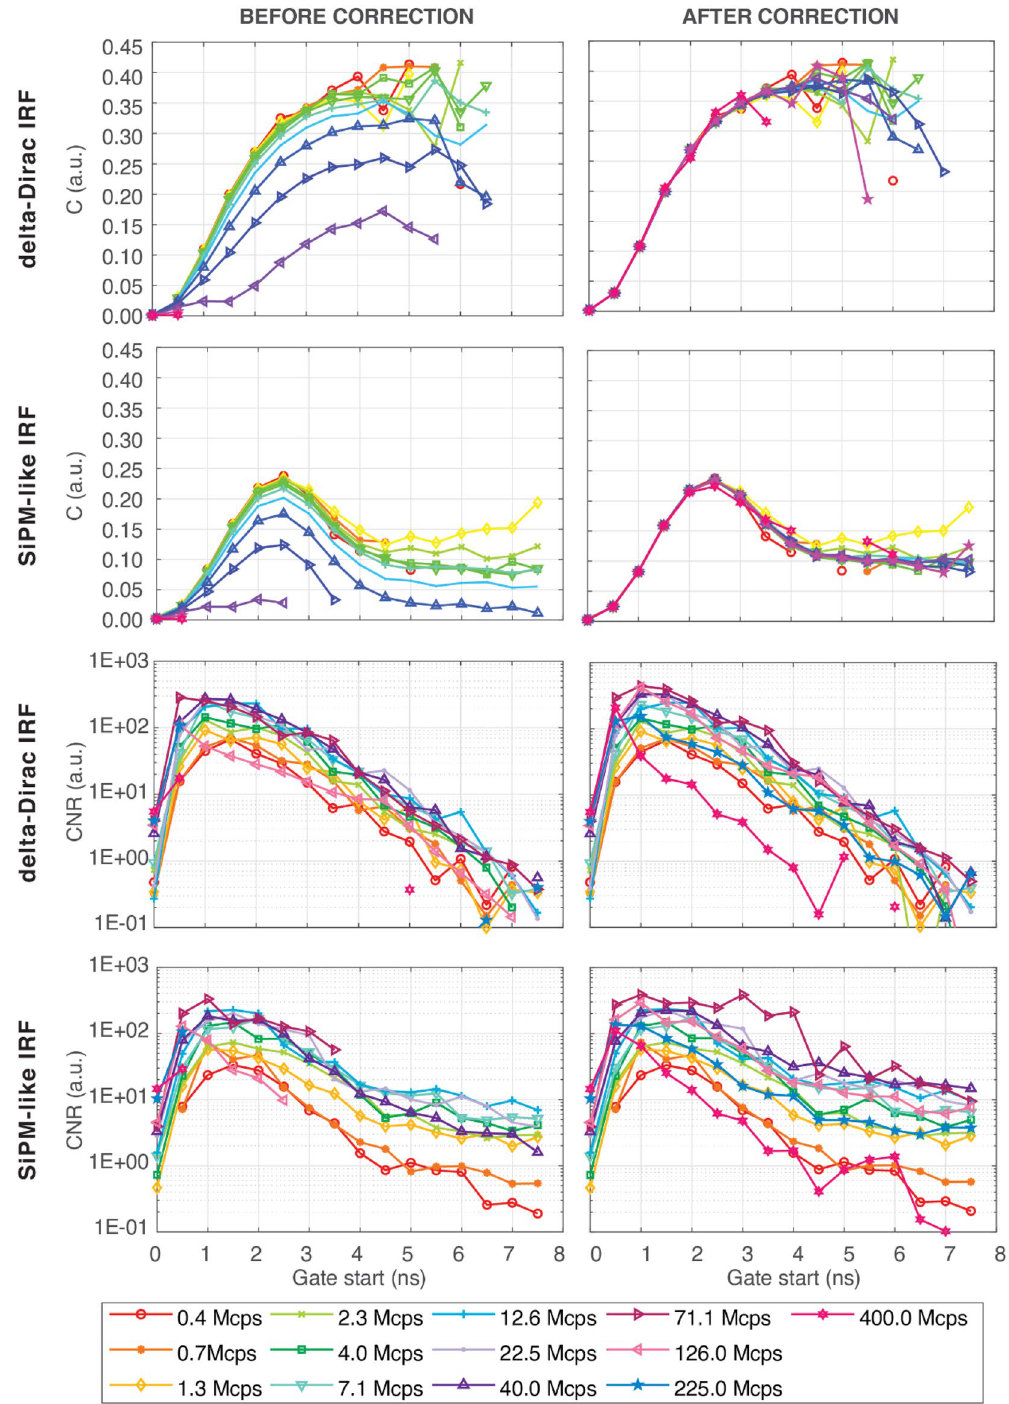
Figure 3. nEUROPt protocol results for simulated data. Values obtained with delta-Dirac IRF are in odd rows, while those obtained with a SiPM-like IRF are in even rows. Contrast (first and second rows) and CNR (third and fourth rows) values are shown at subsequent gates (evaluated from the IRF peak) for different CRs (colours and markertypes). In all cases, both results before (left plots) and after (right plots) pile-up correction are